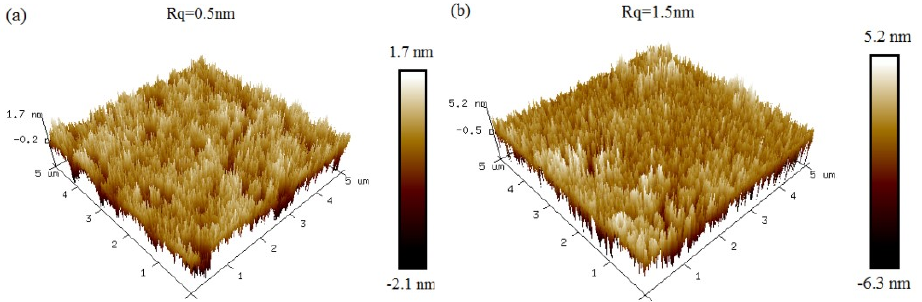
Figure 3. AFM images of slab waveguides: ( a ) an ion-exchanged glass waveguide with the exposed surface; ( b ) an ion-exchanged glass waveguide covered with the sputtered Ta 2 O 5 film.